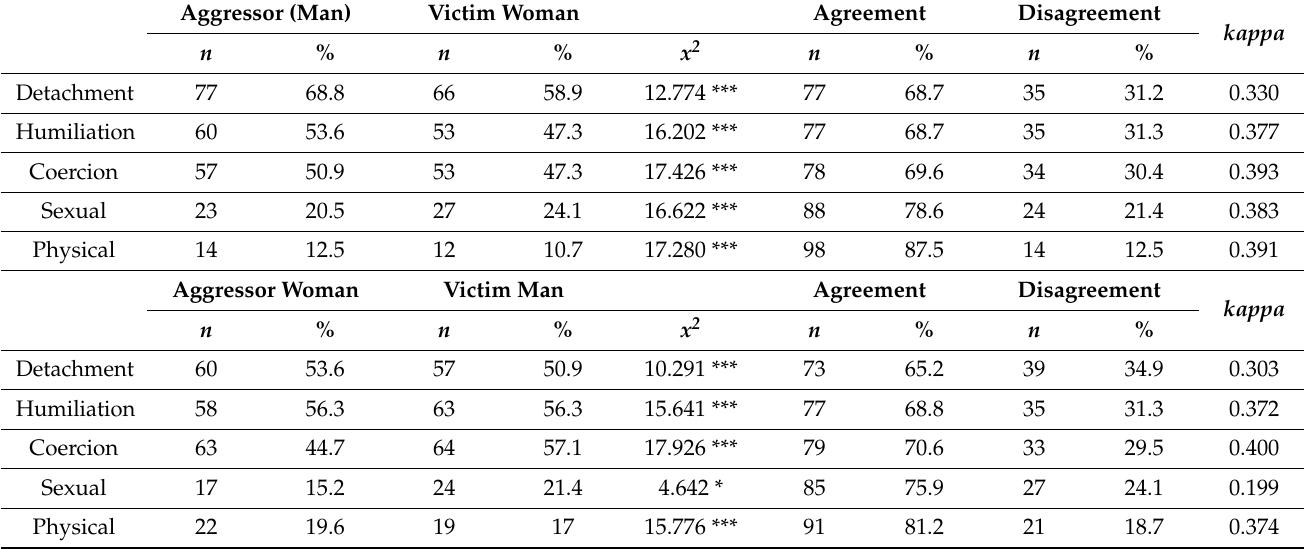
Table 4. Agreement on the occurrence of the factors of violence (DVQ-R) in violent couples differentiated by role (man aggressor-woman aggressor/man victim-woman